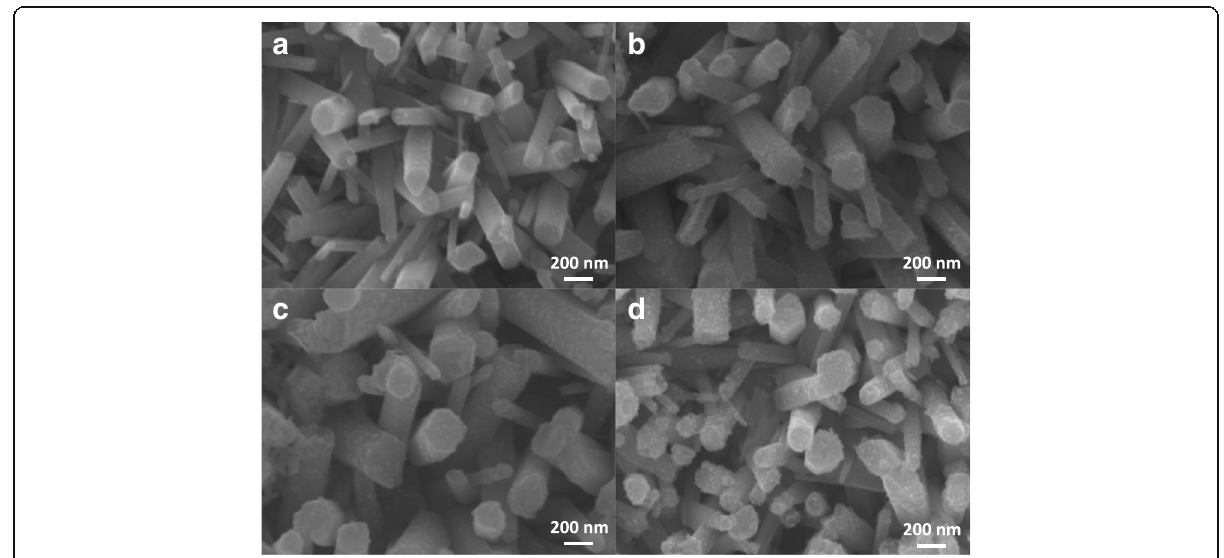
Fig. 8 a – d SEM images of Ag/ZnO NRs with photoreduction times of 1, 1.5, 2, and 2.5 min,